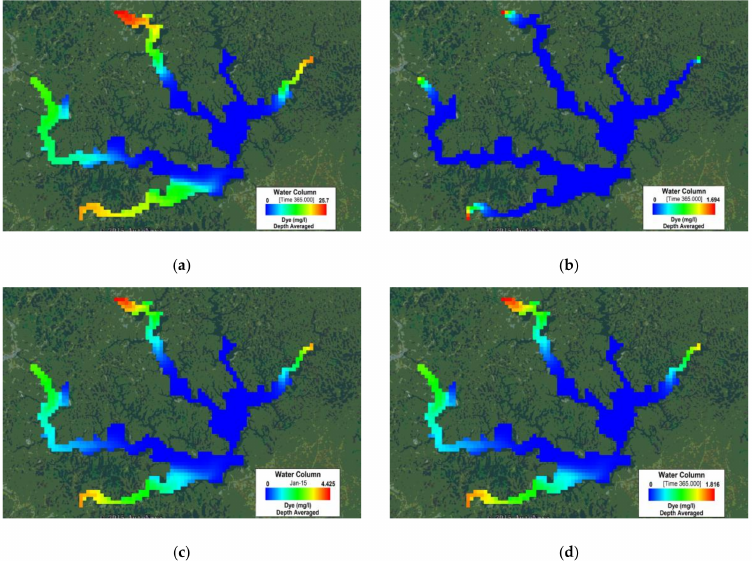
Figure 5. The simulated concentration distribution of COD, NH 3 -N, TN, and TP in Huangshi Reservoir in 2025. (( a ) COD, ( b ) NH 3 -N, ( c ) TN and ( d )